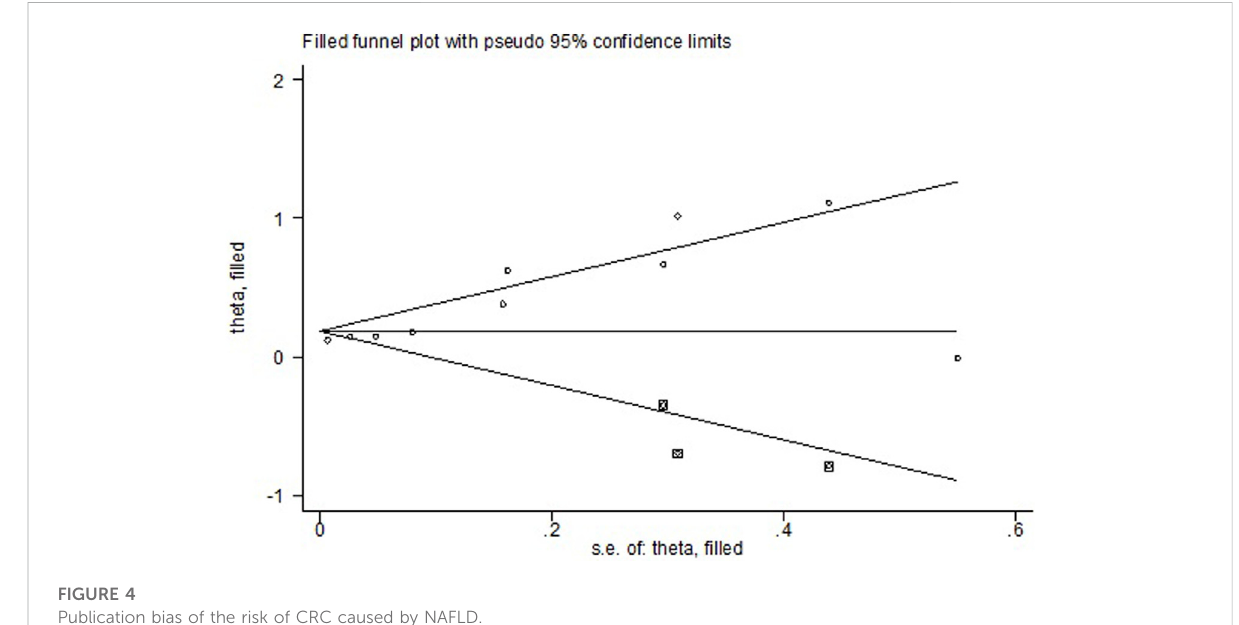
Publication bias of the risk of CRC caused by NAFLD.